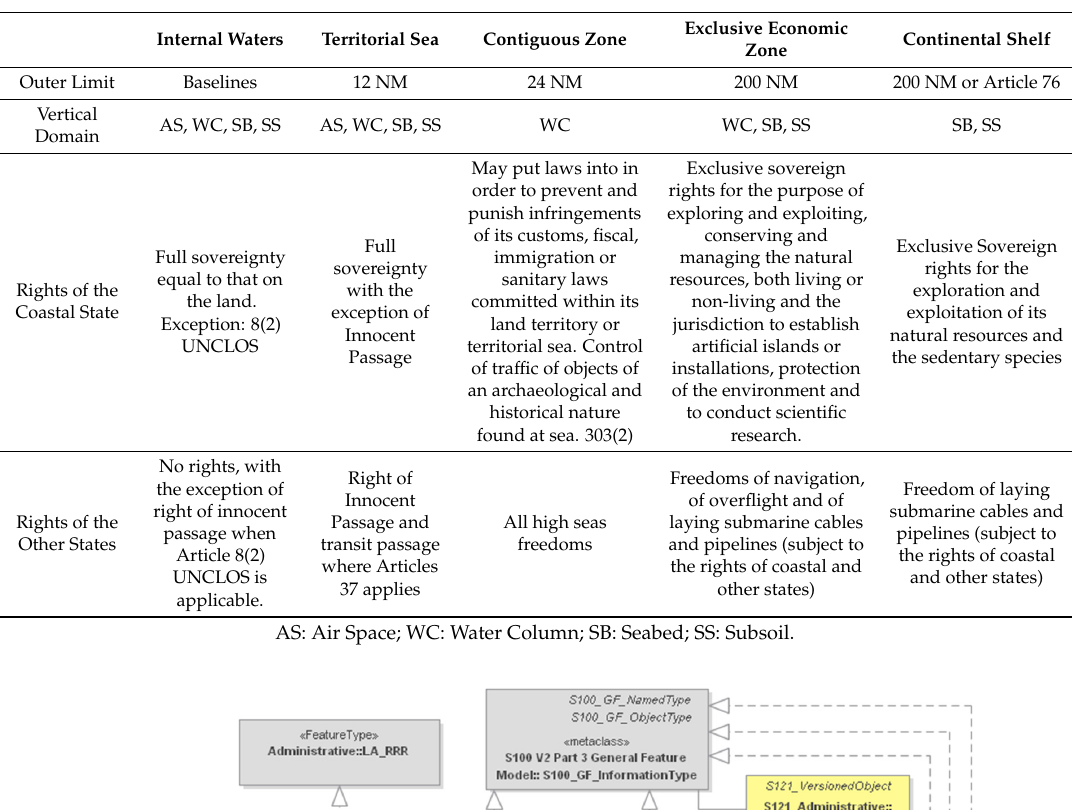
Table 1. Rights of states within maritime zones.